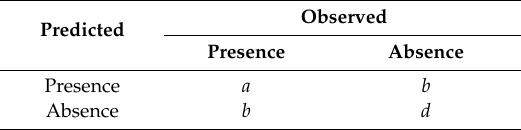
Table 4. Confusion matrix for the evaluation of our presence–absence